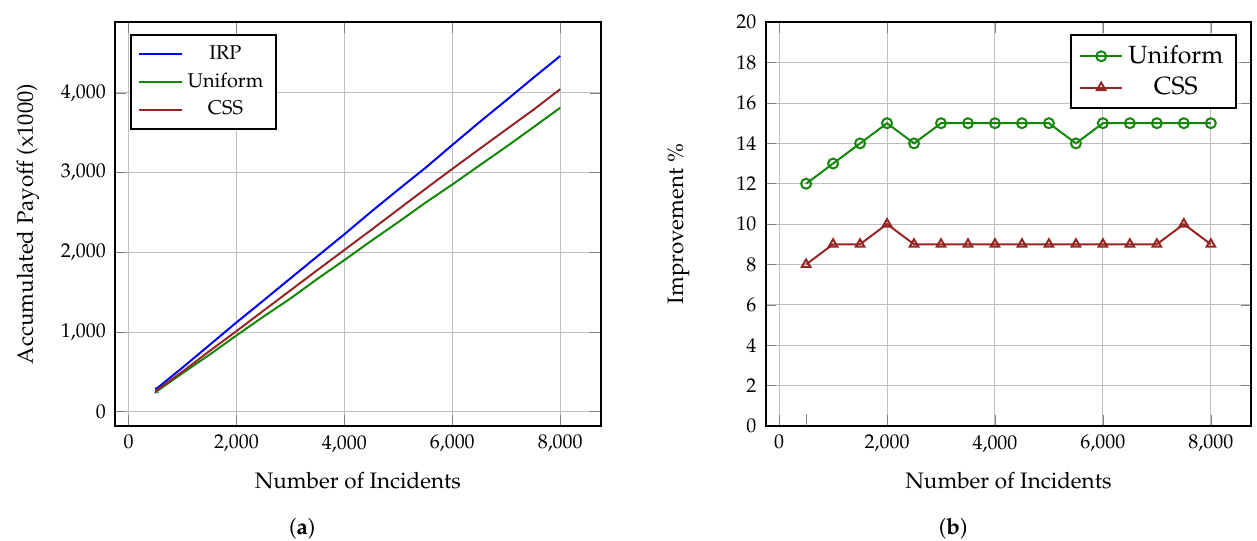
Figure 4. Performance comparison of IRP, Uniform and CSS on N = 8000 simulated incidents against Uniform Attacker. ( a ) Accumulated payoff, ( b ) Percentage of IRP improvement.